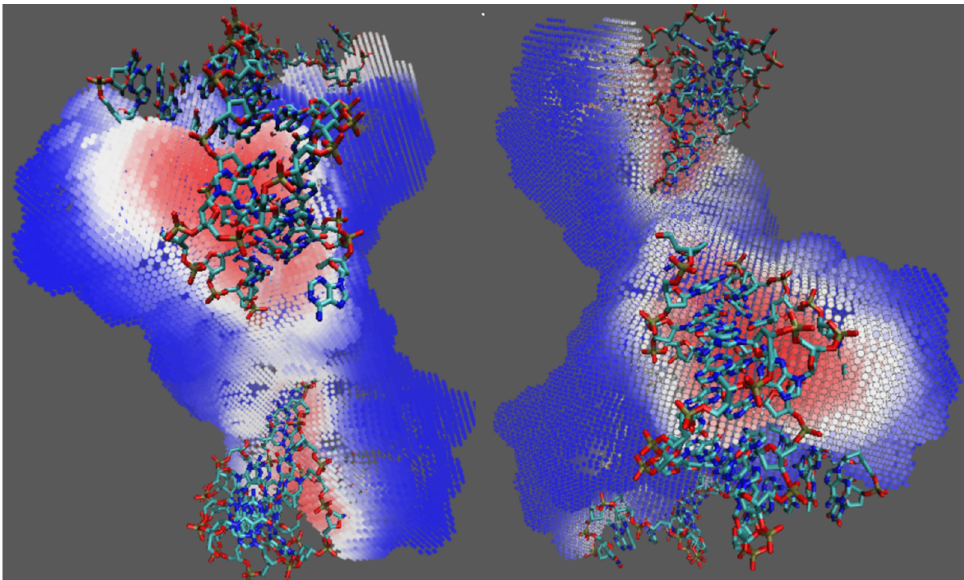
Figure 3. Prediction results for 2xma. The structure was rotated around 150 degrees and presented parallelly.